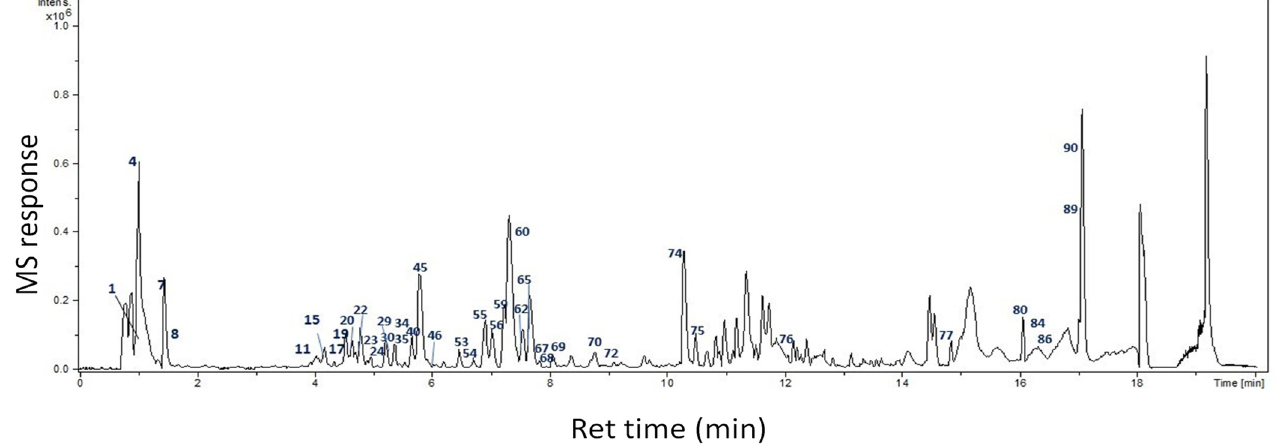
Figure 1. UPLC-QTOF–MS base peak chromatogram of CLEE in negative ion mode. Peaks are numbered following that listed in Table 1.